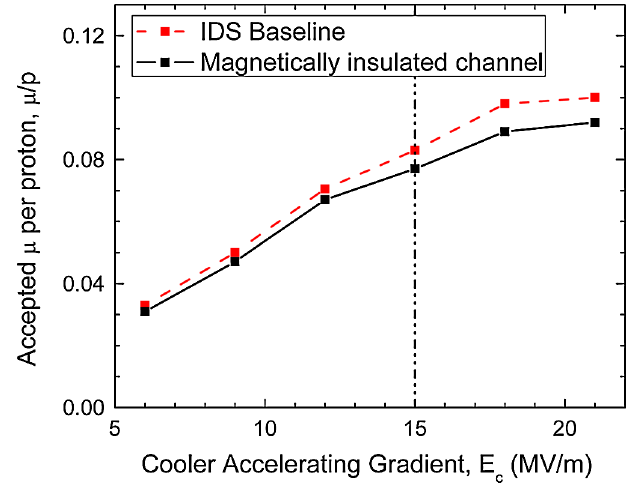
FIG. 9. Simulation results of the effect of maximum rf gradient on the neutrino factory front end. Note that both buncher and rotator gradients remain fixed as described in Table I. The dashed vertical line shows the baseline accelerating